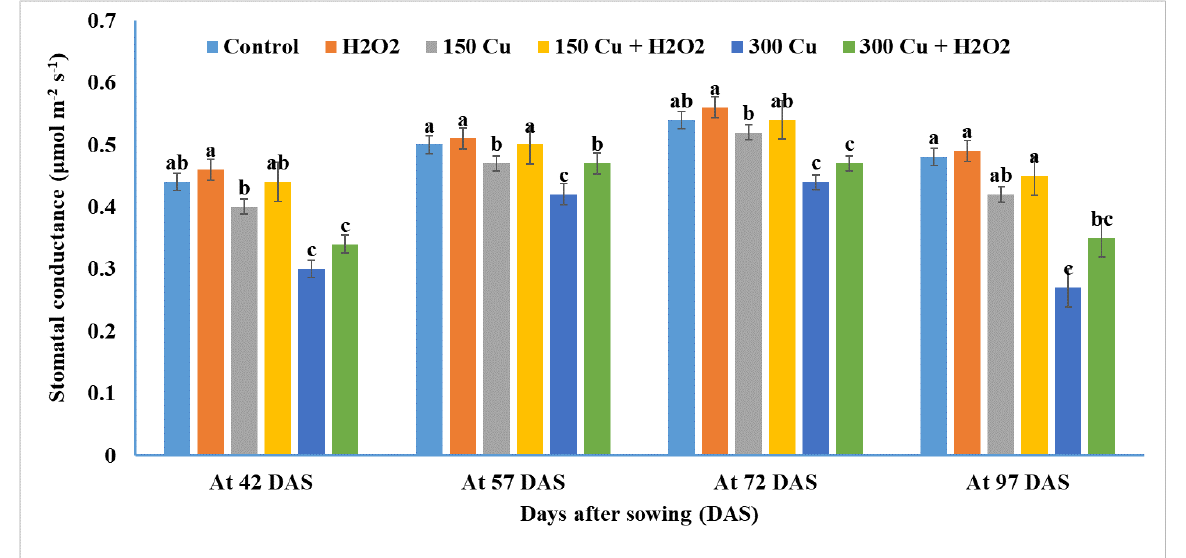
Figure 6. Effect of hydrogen peroxide on stomatal conductance at 42, 57, 72, and 97 DAS of wheat grown in contaminated sandy soil. Means followed by the same letter at each sampling date are not significantly different according to the least significant differences (LSD) test ( p ≤ 0.05). Error bars are ± Standard Error